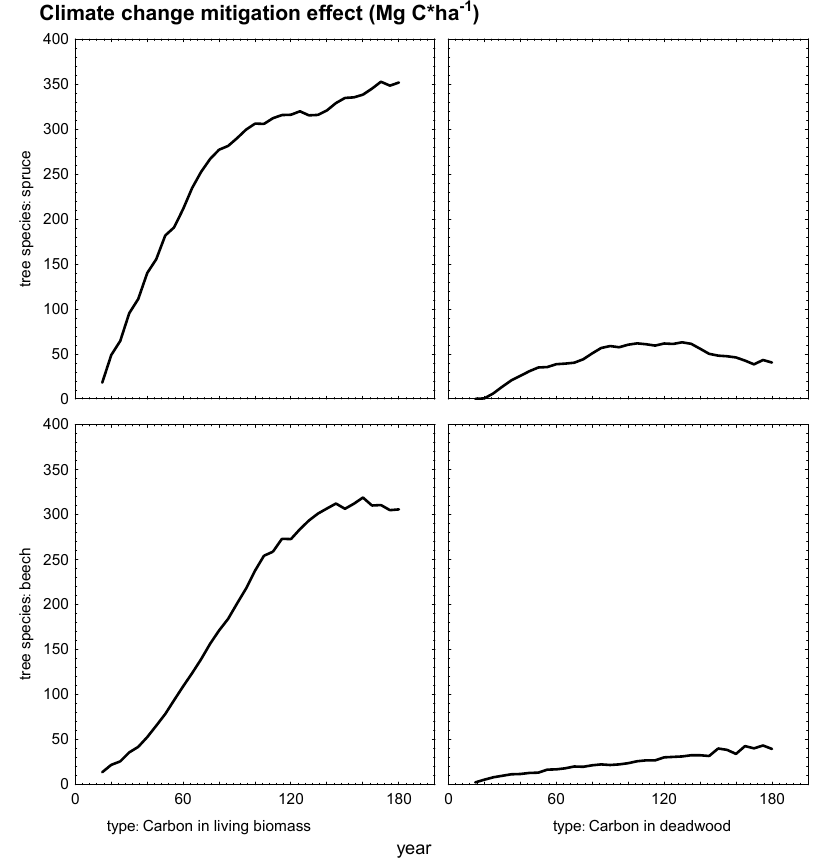
Figure 7. Climate change mitigation effects (Mg C ha − 1 ) for spruce and beech in the unmanaged